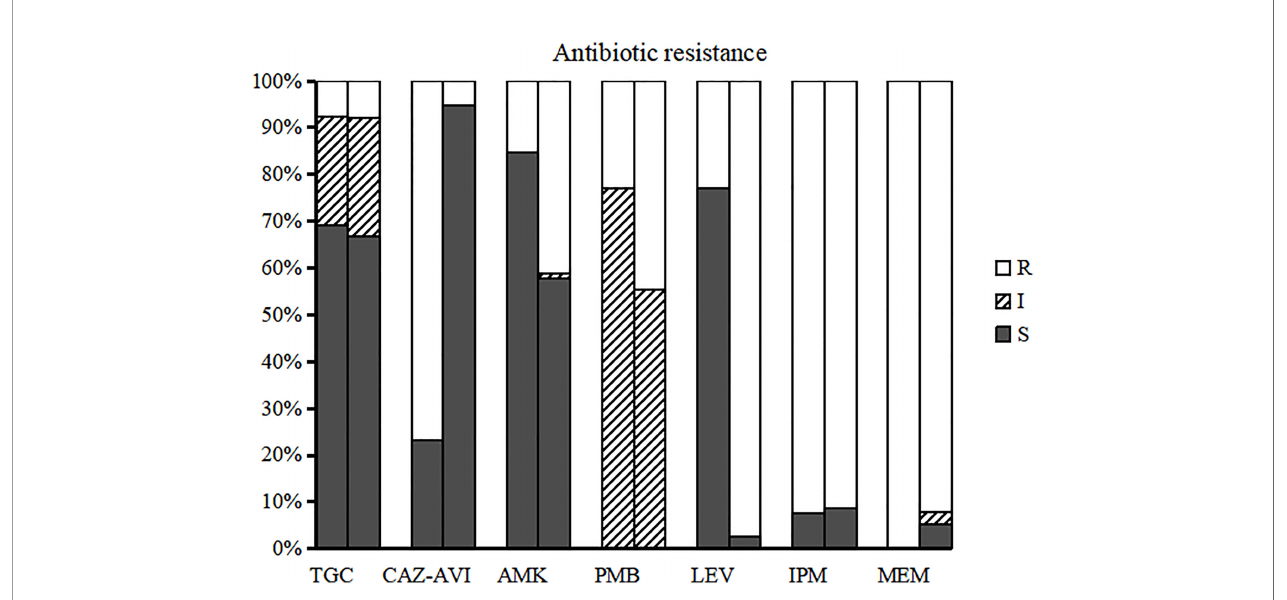
FIGURE 1 | Susceptibility of CRKP to different antimicrobial agents in children and adults. The left bar for each group represents the antibiotic resistance of children and the right bar represents adults. TGC, tigecycline; CAZ-AVI, ceftazidime-avibactam; AMK, amikacin; PMB, polymyxin B; LEV, levo fl oxacin; IPM, imipenem; MEM,